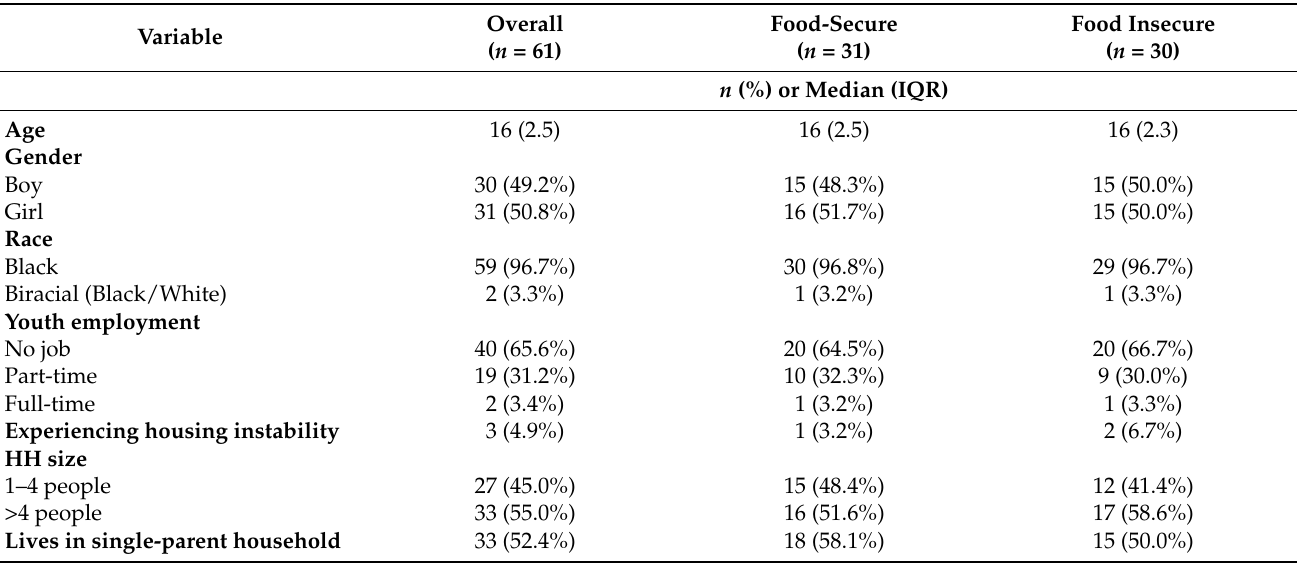
Table 1. Demographic characteristics of adolescents aged 14–19 living in Baltimore by food security status ( n =